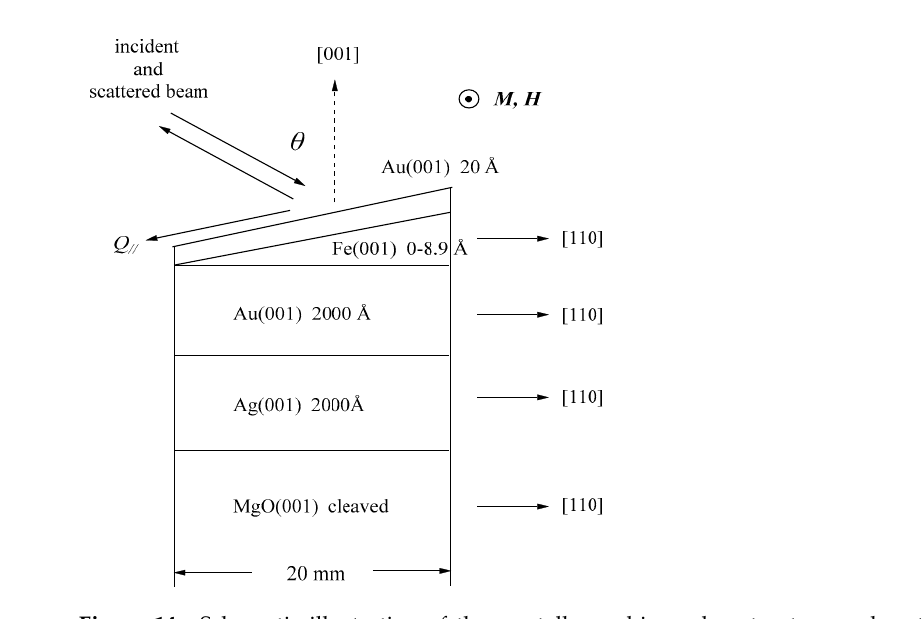
Figure 14. Schematic illustration of the crystallographic wedge structure and scattering geometry [79].